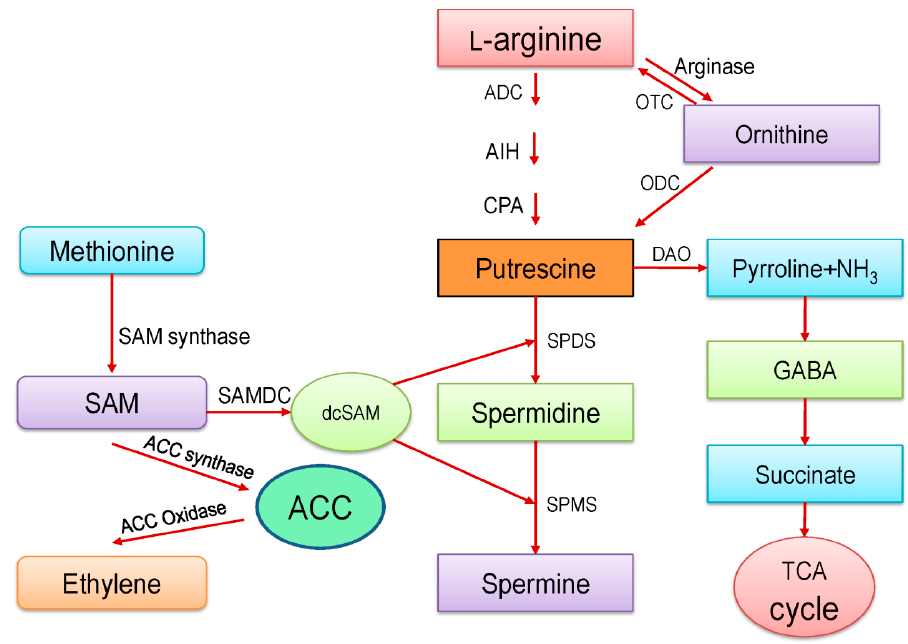
Figure 1. Biosynthesis pathway of polyamines in plants. ADC: arginine decarboxylase; AIH: agmatine iminohydrolase; CPA: N-carbamoylputrescine amidohydrolase; SPDS: spermidine synthase; SPMS: